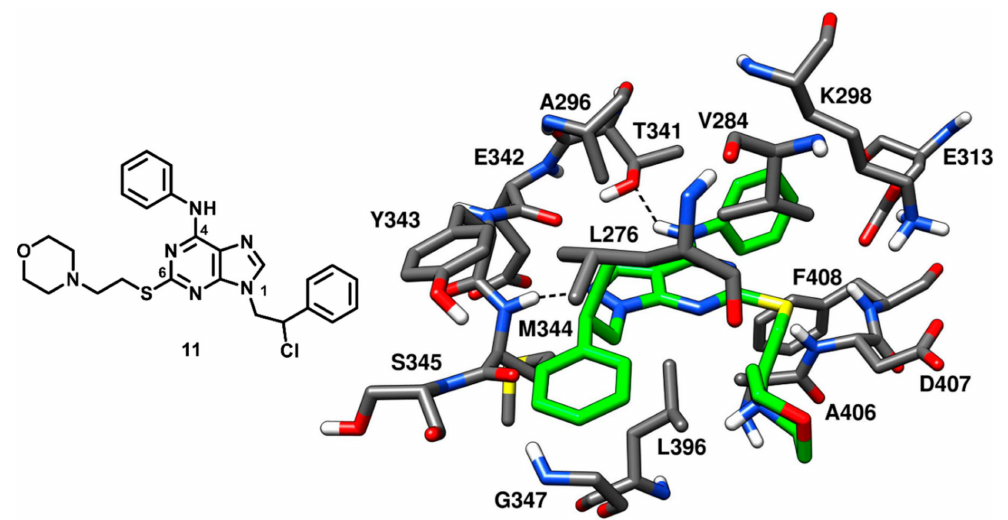
Figure 12. 2D structure of 11 and X-ray structure of c-Src kinase in complex with 11 (PDB ID: 4O2P). Active site residues of c-Src kinase and the enzyme–inhibitor H-bond interactions are